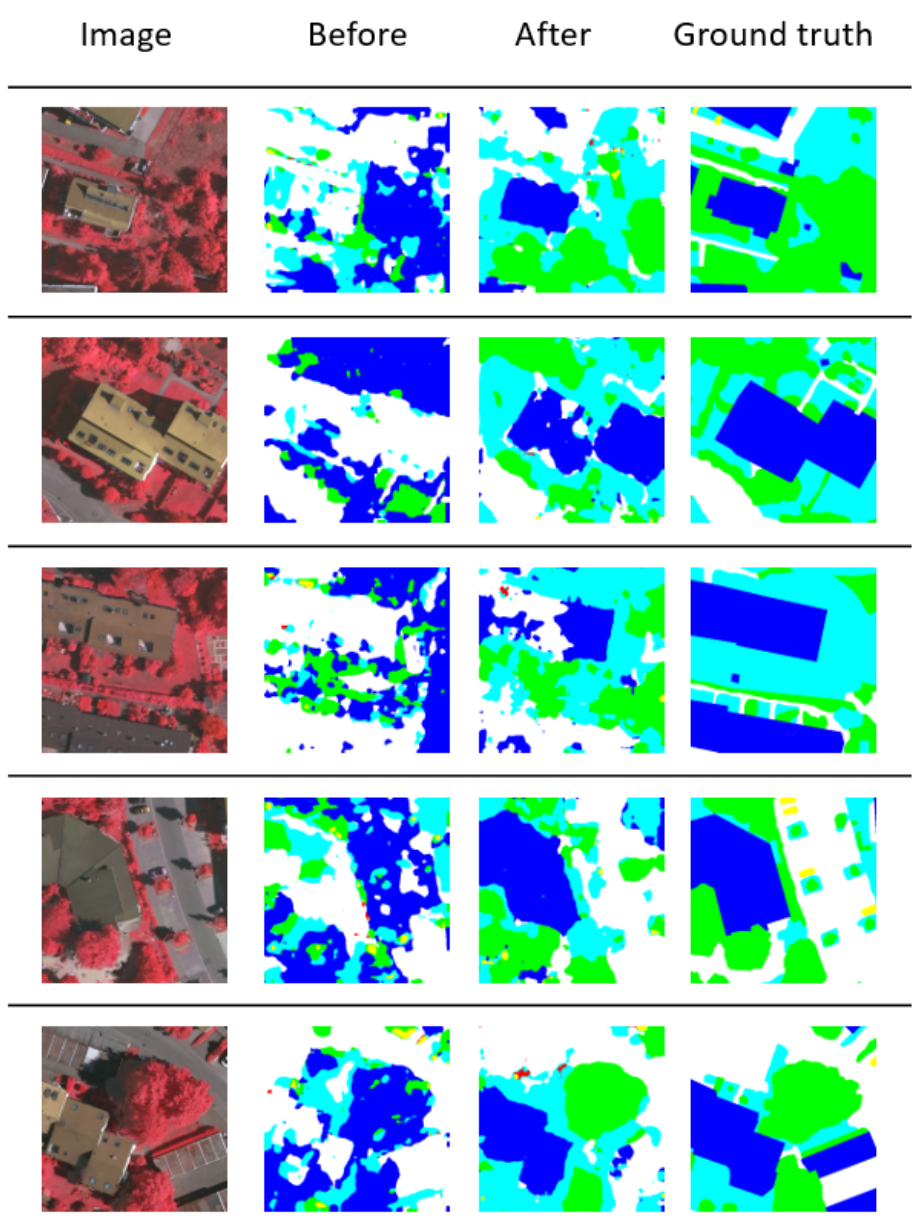
Figure 11. Segmentation of images from the target domain before and after application of our proposed algorithm. Table 3. Segmentation Accuracy, Precision, Sensitivity, Dice Coefficient and IoU score for different numbers of sampled images from the target domain (Potsdam as source and Vaihingen as target). Number of Images from